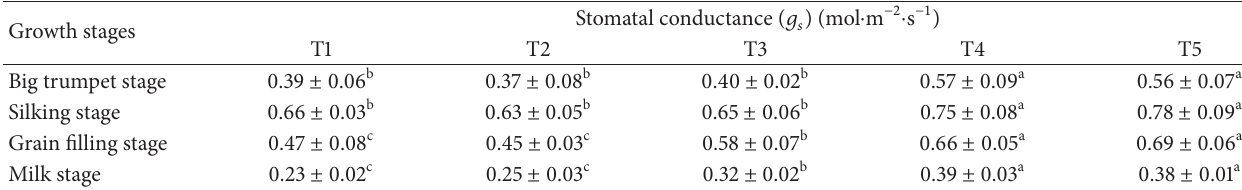
Table 4: Effects of silicon on stomatal conductance ( 𝑔 𝑠 ) in leaves of maize.